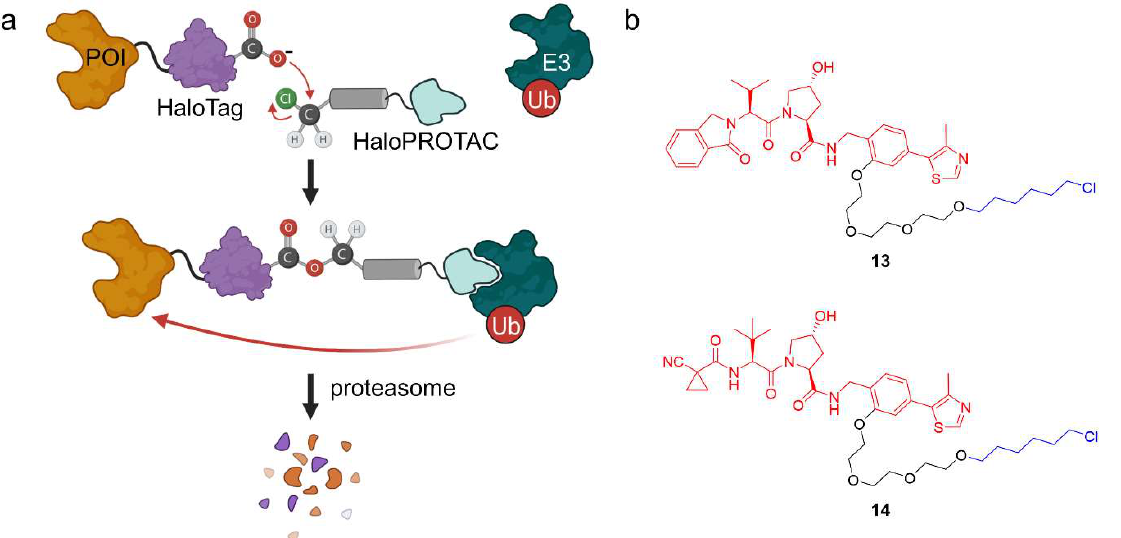
Figure 10. HaloPROTACs and their mode of action. ( a ) HaloPROTACs specifically target engineered HaloTag7 fusion POIs for degradation in a modular way. They bind to an E3 ubiquitin-ligase and, via the reactive hexyl chloride, to the HaloTag protein. ( b ) Chemical structures of two HaloPROTACs. The VHL ligand (VL285 in 13 and VH298 in 14 ) is shown in red, the linker in black, and the hexyl chloride in blue.